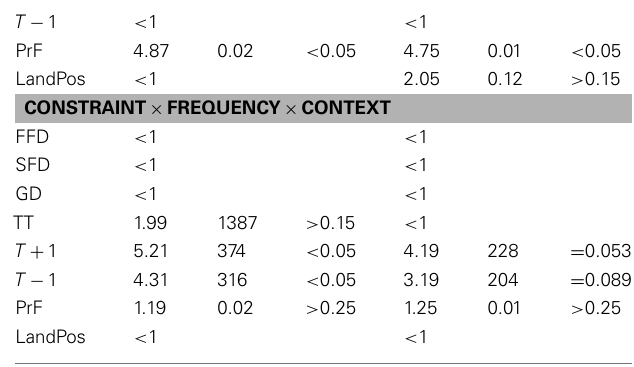
Table 4 | Main effects and interactions by participants ( F 1 ) and by items ( F 2 ) on all measures.